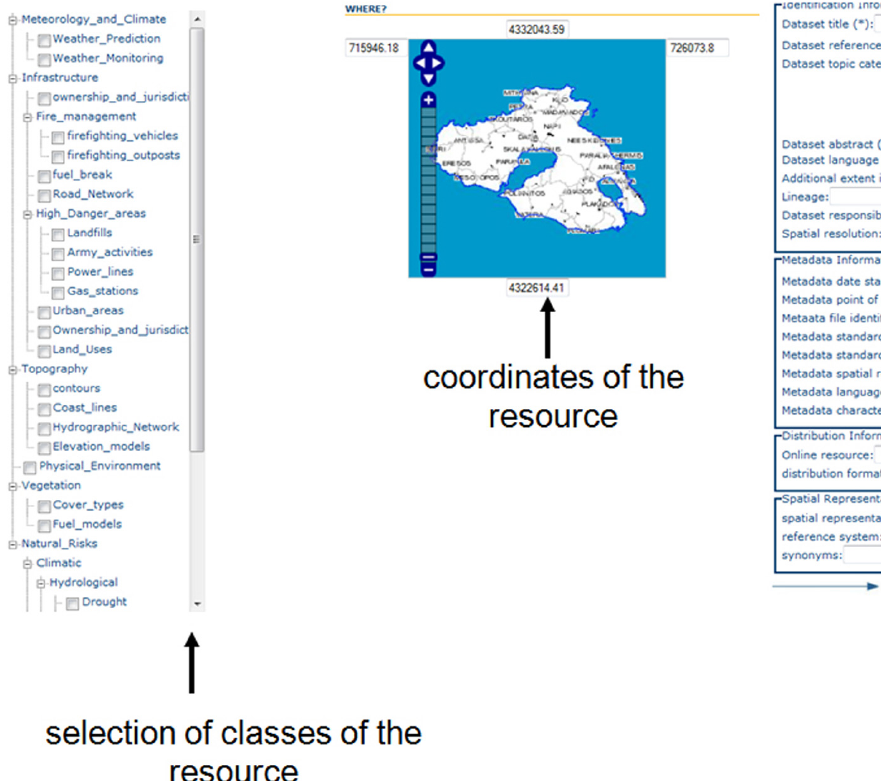
Fig. 13. Metadata publishing in OntoFire.